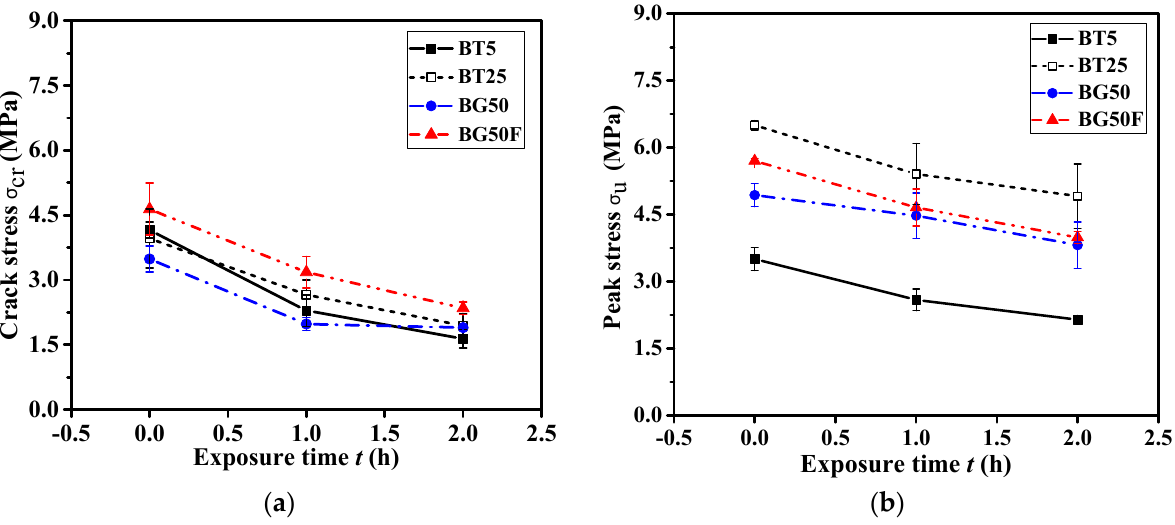
Figure 12. Tensile behaviors of the BGRM after exposure to elevated temperature: ( a ) crack stress; ( b ) peak stress.